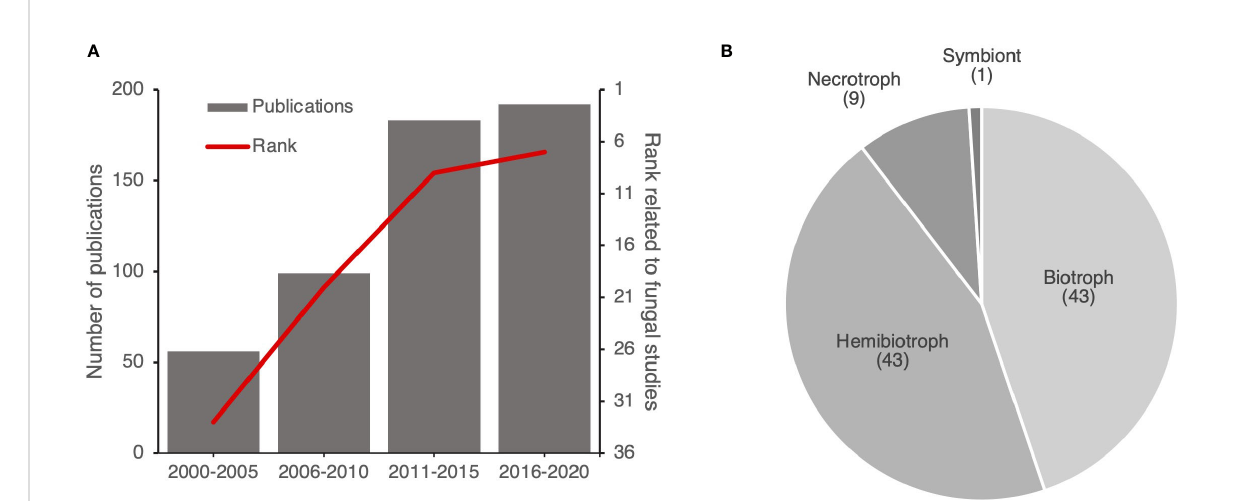
FIGURE 6 Publications addressing effectors of (hemi)biotrophic fungi gain prominence over time. (A) Evolution of the number of publications related to plant pathogen effectors and the citation rank for HIPE-funs. Each citation rank was calculated based on the mean of rank of publications by time frames ( i.e. position of the publication on the Web of Science website based on the number of citations). (B) Pie chart displaying the proportion of each lifestyle of plant pathogenic fungi studied in the HIPE-funs. The categorization of each lifestyle was based on iterative expert reading and association with the pathogenic species studied for the entire HIPE-fun collection. Numbers above lifestyle topics indicate the total number of HIPE-funs for each topic. The raw data used to build this fi gure are available in the Dataset